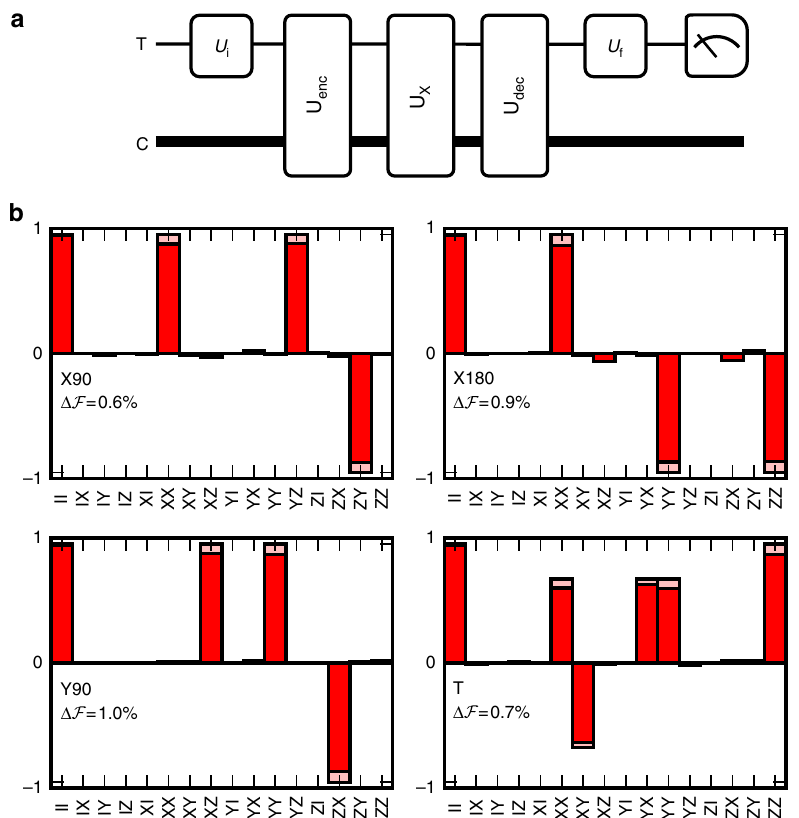
Fig. 3 Process tomography of operations on encoded qubit. a In order to characterize a gate U X on the encoded qubit, transmon process tomography is performed on the operation U dec U X U enc . Process tomography is implemented by performing an initial transmon rotation U i right after state preparation (Supplementary Note 3), as well as a fi nal transmon rotation U f , right before measurement of the transmon. b Process tomography results for selected operations (for additional operations, see Supplementary Fig. 5). The process tomography yields an estimated quantum channel G. We represent this channel in the Pauli transfer representation. The bar labeled with operators AB ( A , B ϵ {I,X,Y,Z}, the Pauli basis matrices) represents Tr( A G( B ))/2. Red and pink bars indicate the experimental and ideal values, respectively. The in fi delity Δ F PT of operation U X is estimated as the difference between F PT ð U dec U X U enc Þ and F PT ð U dec U enc Þ ¼ 0 : 964. The selected set of operations, {X180,X90,Y90,T}, allows universal control of the logical